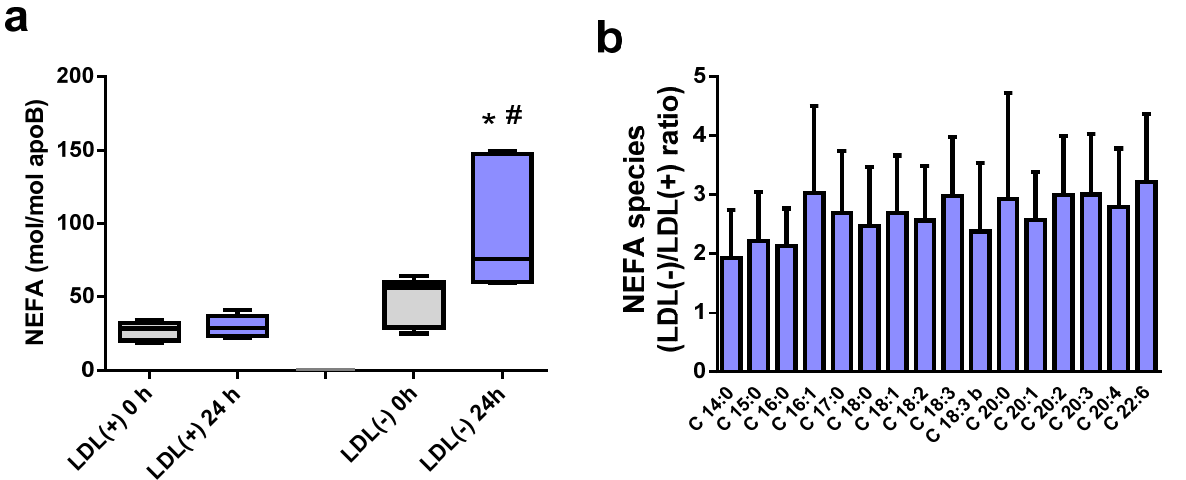
Figure 2. Non-esteri fi ed fa tt y acid (NEFA) content in LDL(+) and LDL( − ), basal and after 24 h of